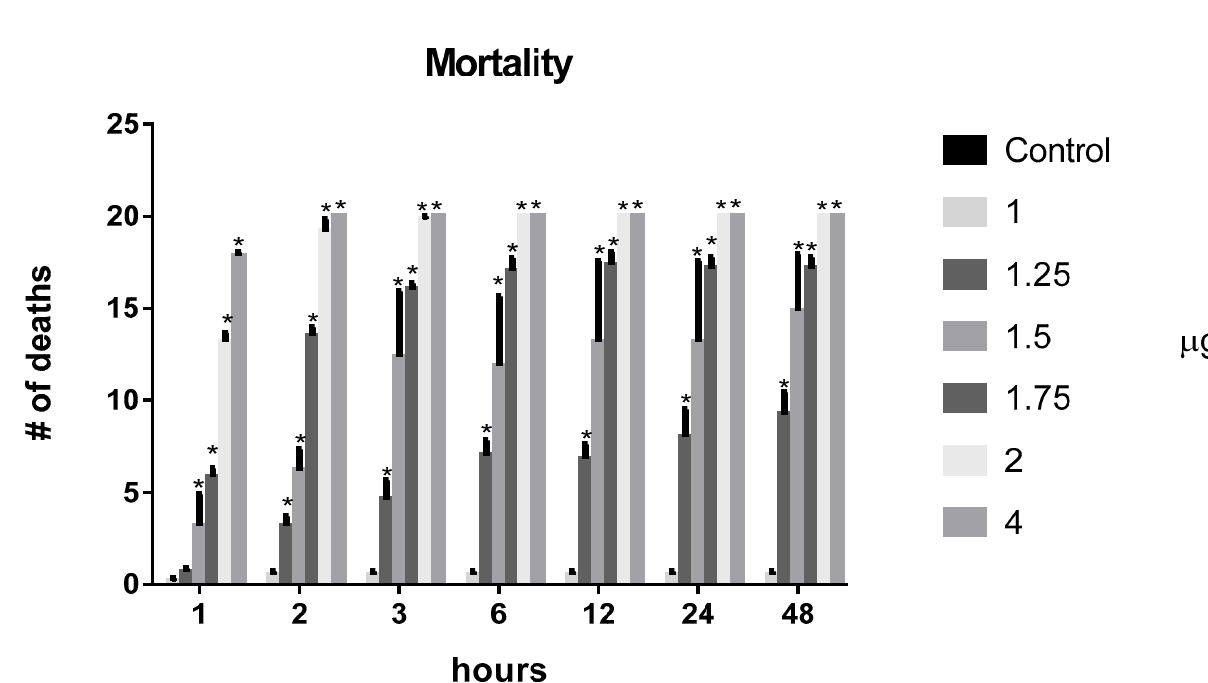
Figure 3. Effect of the benzaldehyde on D. melanogaster survival. Subtitles: Survival was analyzed at the indicated time points. Results are expressed as the Mean ± SD of the number of dead flies after each exposure time. * = p < 0.05 compared to the control.